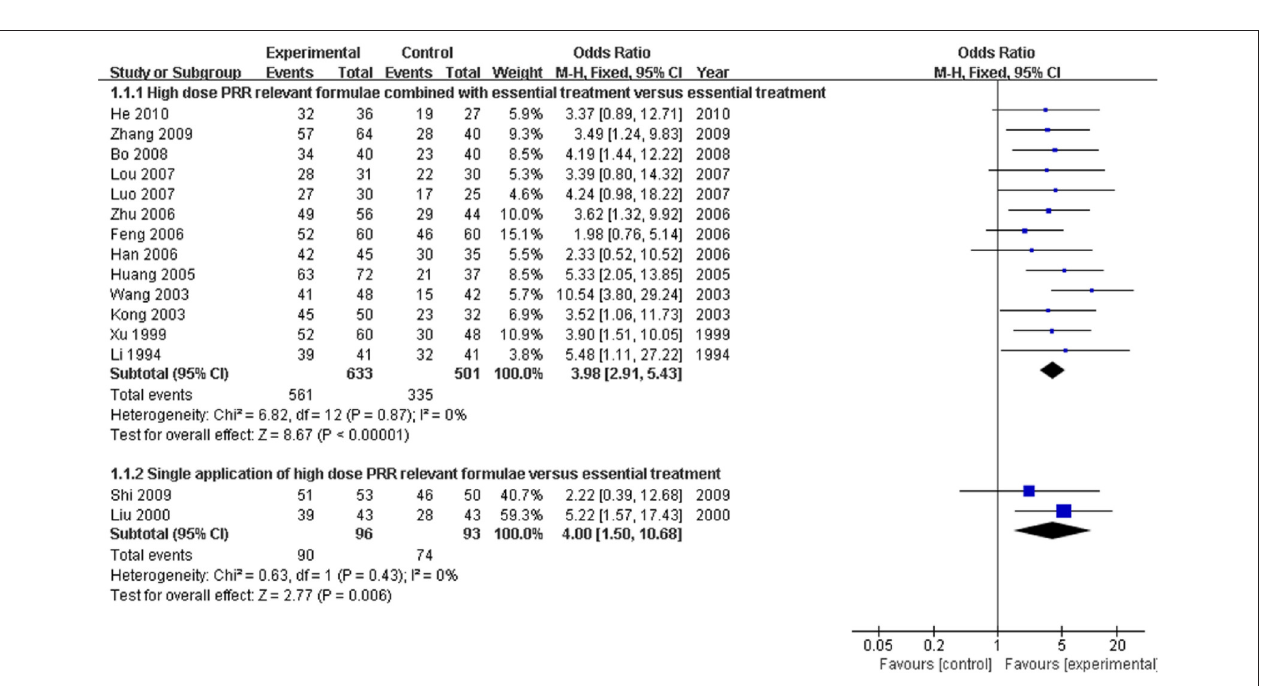
FIGURE 4 | Forest plot of high-dose PRR-relevant formulae with essential treatment or single application vs. essential treatment in viral hepatitis patients with hyperbilirubinemia. (1) Study item displayed as first author with the publication year. (2) Subgroups were divided by formulae combined with essential treatment or single application. (3) I-squared and P are the criterion of the heterogeneity test, (cid:7) pooled odds ratio, — (cid:4) — odds ratio, and 95% confidence